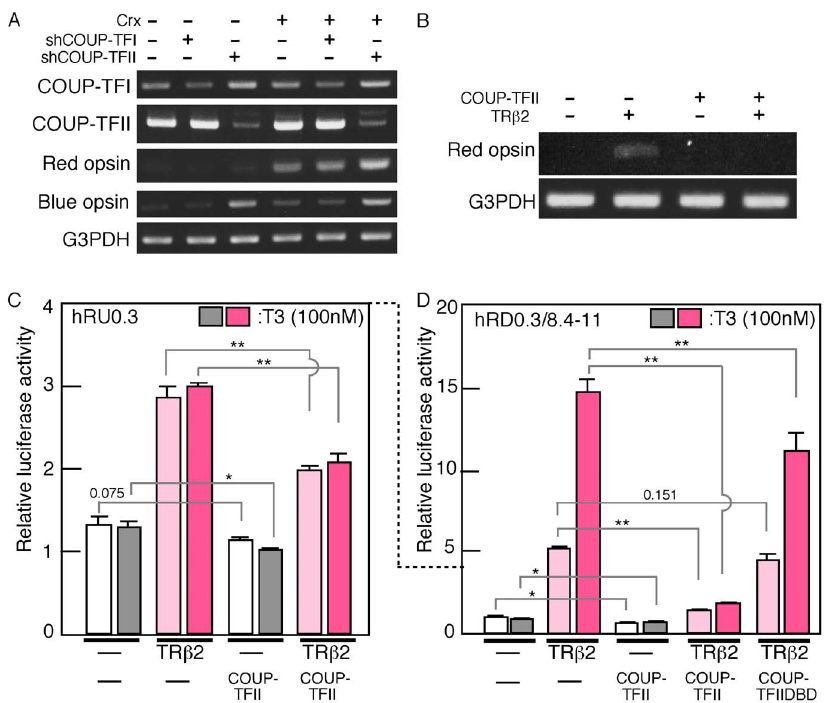
Figure 3. Effects of COUP-TFII for human red opsin promoter activities. A, B. Plasmids encoding U6-sh-COUP-TFI or U6-sh-COUP-TFII with/ without Crx expression plasmid were transfected into Y79 (A). Expression plasmid of COUP-TFII and/or TRß2 were transfected to HEK293T (B) cells. Transfected cells were harvested after two days. Then expression of COUP-TFI, COUP-TFII, red opsin, and blue opsin (A), and red opsin (B) was examined by semi-quantitative RT-PCR. G3PDH was used as a control (A, B). C, D. Human red opsin luciferase constructs, hRU0.3 (C) or hRD0.3/8.4–11 (D) was transfected into HEK293T with TRß2 expression plasmid or a control vector, and cultured for 12 hours, T3 (100 nM) was added half of samples and cultured additional 16 hours. p value; ** , 0.01, * , 0.05, or actual value was calculated by Student’s